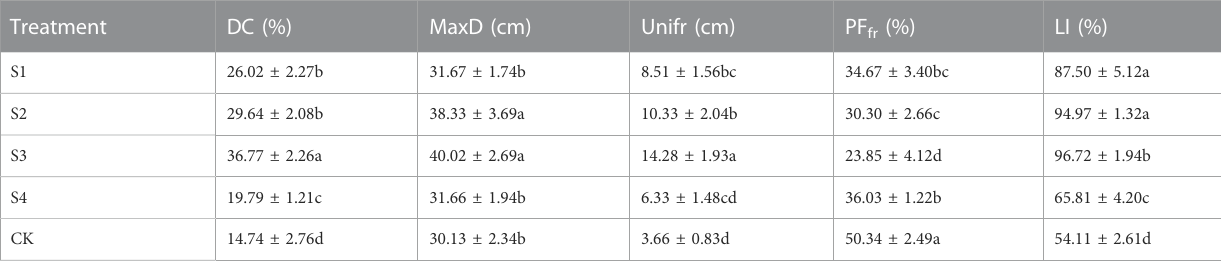
TABLE 1 preferential fl ow